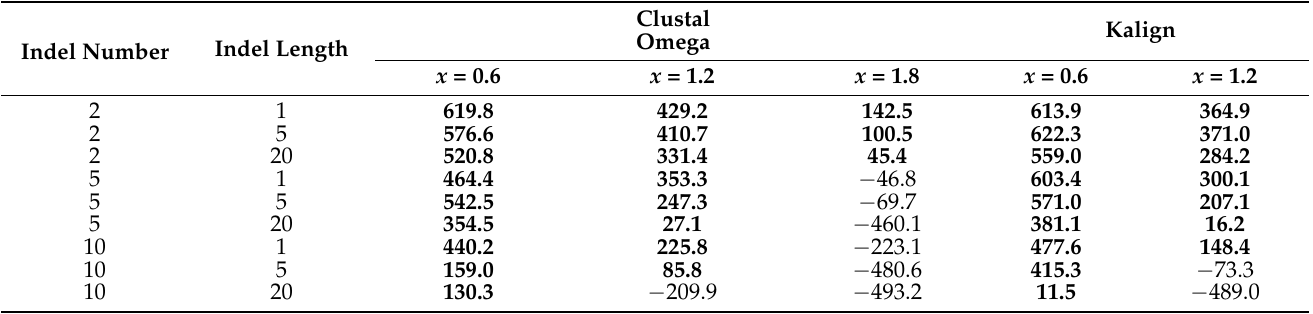
Table 4. Z values calculated for multiple alignments of 81 Des sets constructed using Clustal Omega and Kalign ( Z values > 10.0 are in